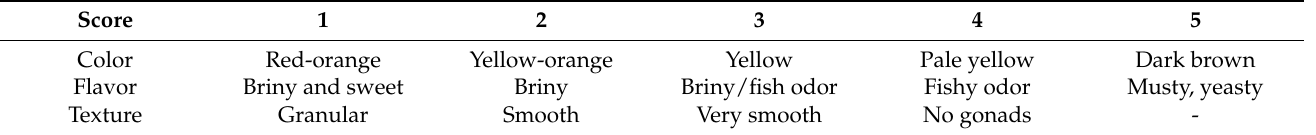
Table 1. Rating system used for the evaluation of sensory characteristics of sea urchin